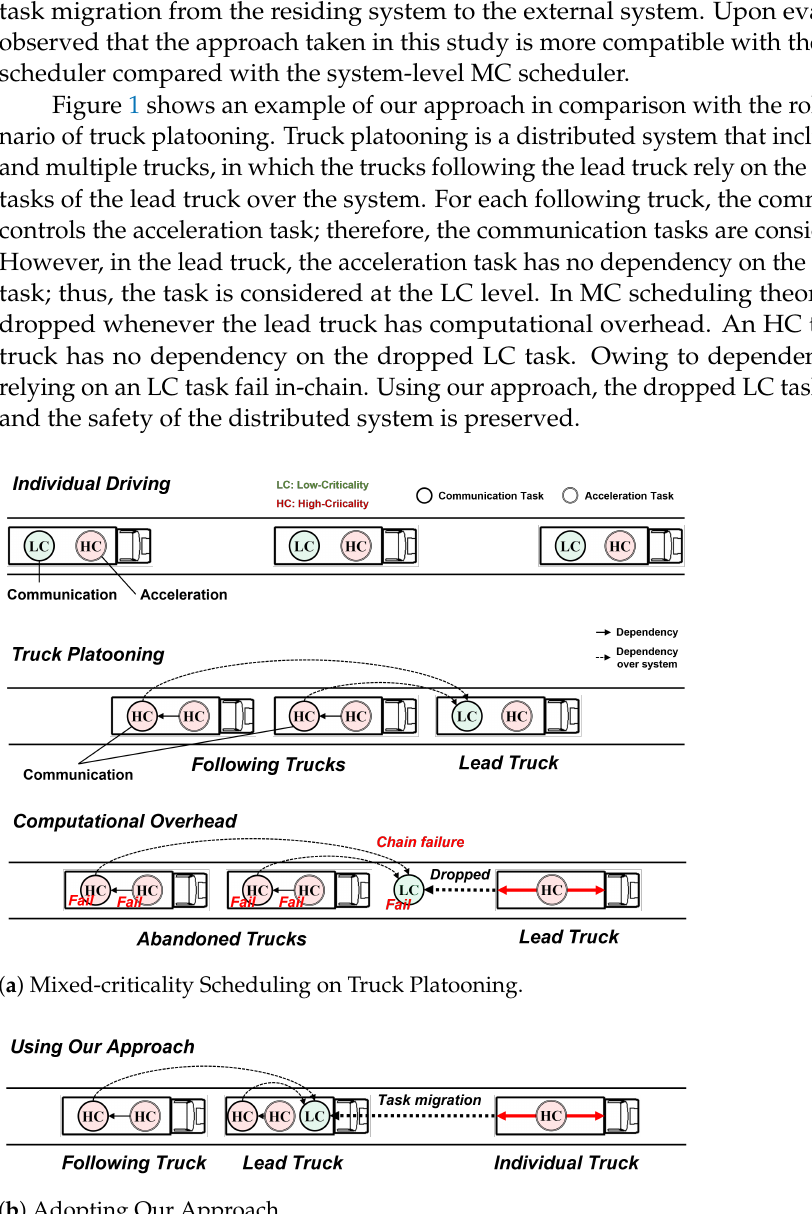
Figure 1. Overcoming the Chain Failure of Mixed-criticality Scheduler by Adopting our